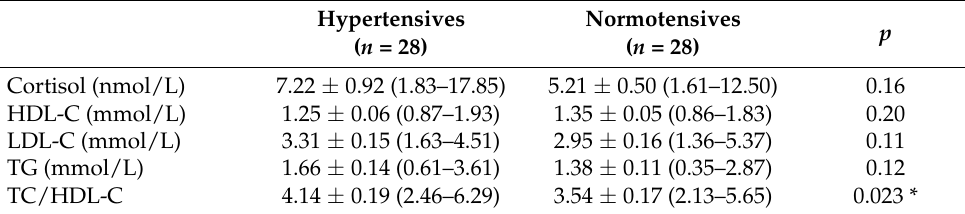
Table 2. Comparison of MIST baseline levels of cortisol and blood lipids in hypertensives and